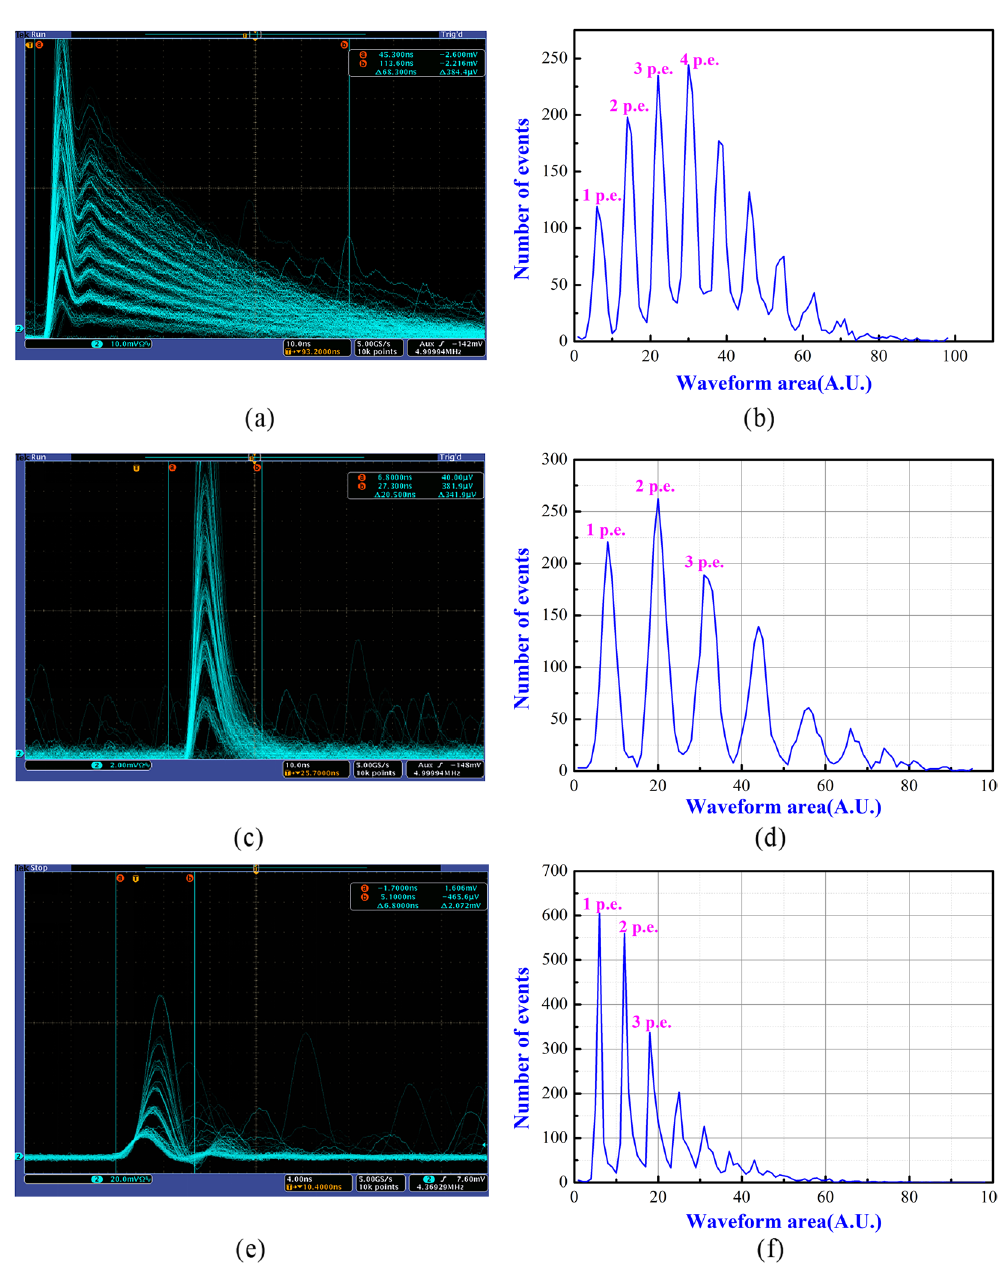
Figure 5. Oscillograph capture and the photon number resolution spectra of the SiPMs employed in this work. ( a ) Oscillograph showing the avalanche pulses from the FBK SiPM (model = NUV-HD-LF) under the irradiation of the focal spot; ( b ) Photon number resolution (histogram of the waveform area) spectrum of the FBK SiPM; ( c ) Waveforms of the avalanche pulses from the NDL SiPM (model = EQR1011-1010C-T) under the irradiation of the focal spot; ( d ) Photon number resolution spectrum of the NDL SiPM; ( e ) Oscillograph showing the avalanche pulses from the Hamamatsu SiPM (model = S12571-010C) under the irradiation of the focal spot; ( f ) Photon number resolution spectrum of the Hamamatsu